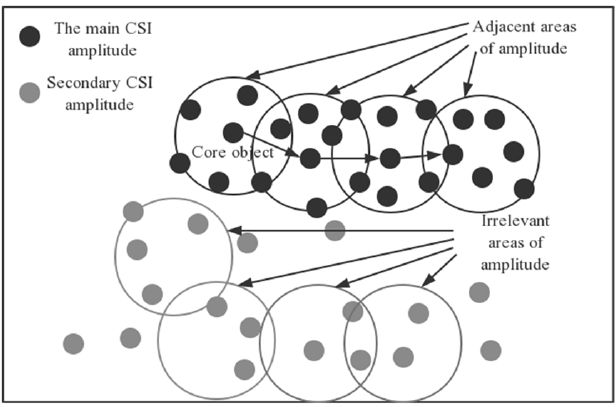
Figure 2. Density-Based Spatial Clustering of Applications with Noise (DBSCAN) algorithm principle.